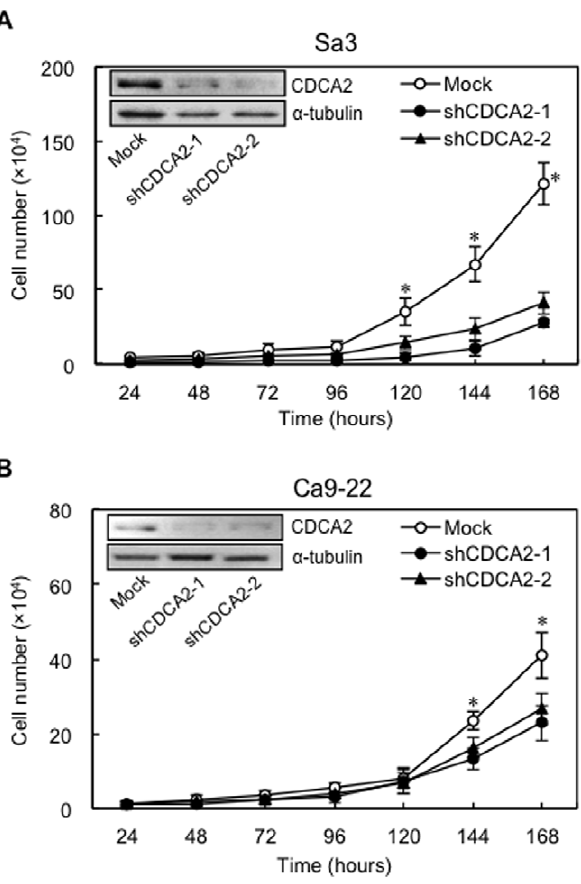
Figure 2. Proliferation of shCDCA2-transfected Sa3 and Ca9-22 cells. The shCDCA2-transfected Sa3 ( A ) and Ca9-22 ( B ) cells (shCDCA2- 1 and shCDCA2-2 correspond to two selected clones) show a significant (* P , 0.05, Mann-Whitney’s U test) decrease in cellular growth compared with the mock-transfected cells. The results are expressed as the means 6 SEM of values from three assays. Representative Western blot data show that CDCA2 proteins are markedly down-regulated in shCDCA2- transfected Sa3 ( A ) and Ca9-22 ( B ) cells. Densitometric CDCA2 protein data are shown in Figure S1C and D.